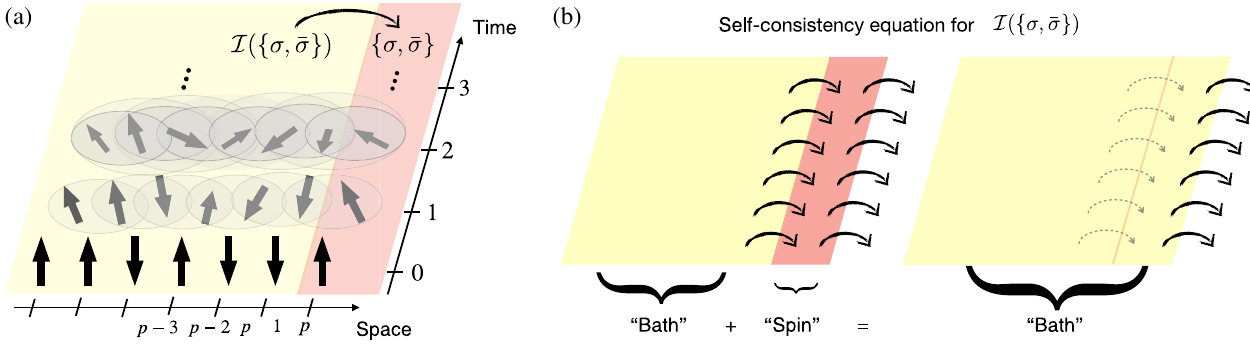
FIG. 1. (a) Illustration of the influence matrix approach to many-body Floquet dynamics. The many-body quantum state of a spin system becomes increasingly entangled due to periodic local interactions and kicks. The influence matrix I , defined in Eq. (15), describes the dynamical effects of all spins k < p on a spin p , in terms of a path-integral weight affecting the trajectories f σ ; ¯ σ g of spin p forward and backward in time. (b) In translationally invariant one-dimensional systems, the influence matrix is the same for all p , which, as illustrated, leads to a self-consistency equation for